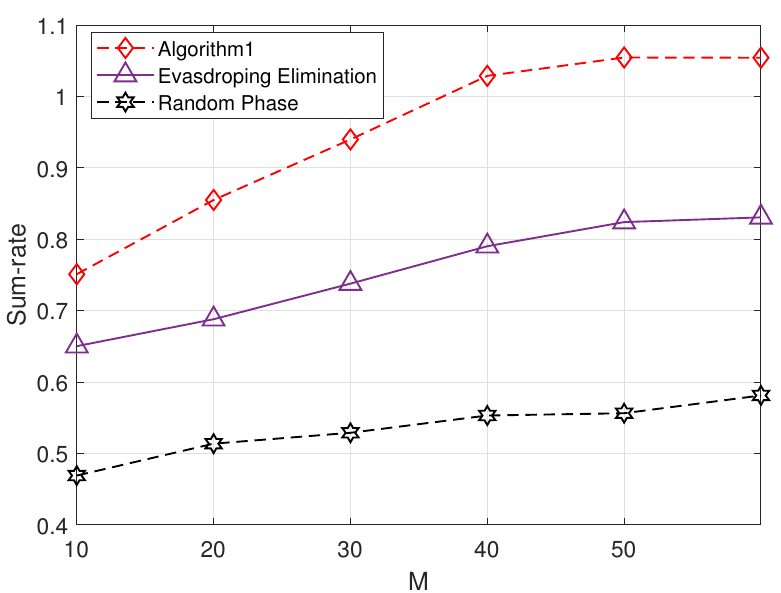
Figure 5. Maximum average secure transmission rate with the reflective units on each RIS for different methods (P = 2.5